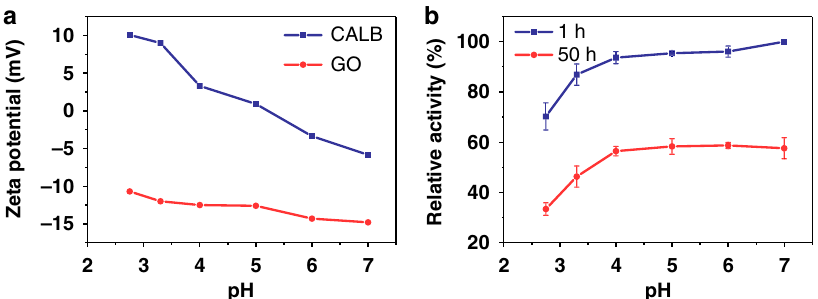
Fig. 2 Properties of free CALB and GO for the optimization of pH in LGA preparation. a Zeta potentials of CALB and GO at various pH; b the relative activity of CALB after incubation at different pH for 1 h and 50 h. Error bars represent the s.d. of three replicates. Source data are provided as a Source Data fi le